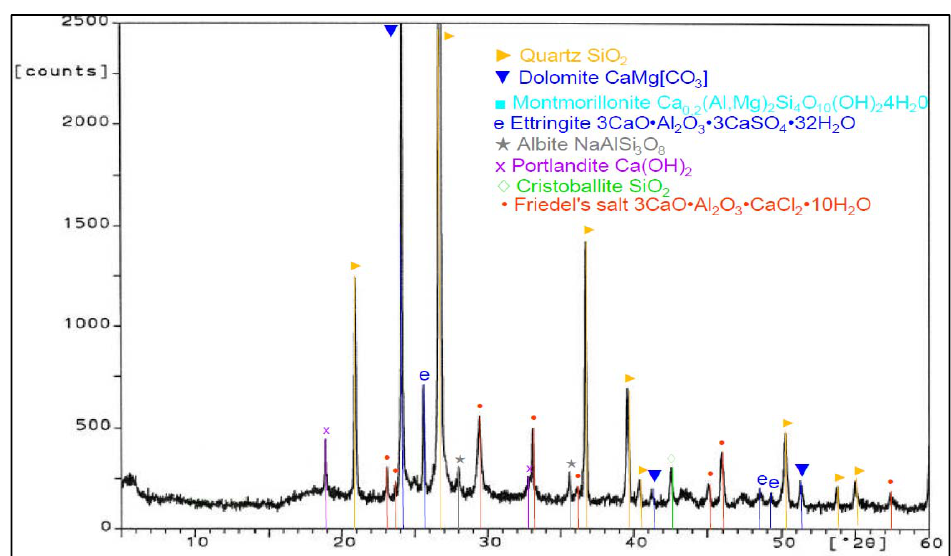
Materials 2021 , 14 , x FOR PEER REVIEW Figure 25. XRD pattern of the ZIII mortar (CEM I + 45% FBC) stored in 1% HCl for 365 days.